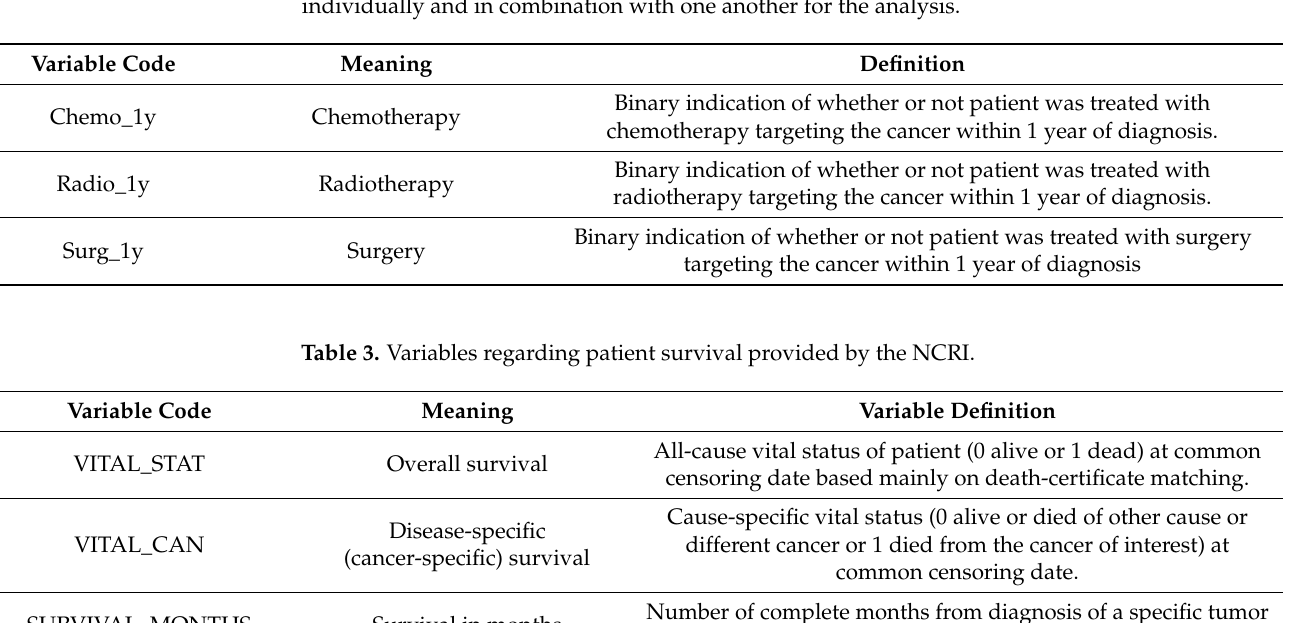
Table 2. Variables regarding patient treatment provided by the NCRI. These variables were used individually and in combination with one another for the analysis.